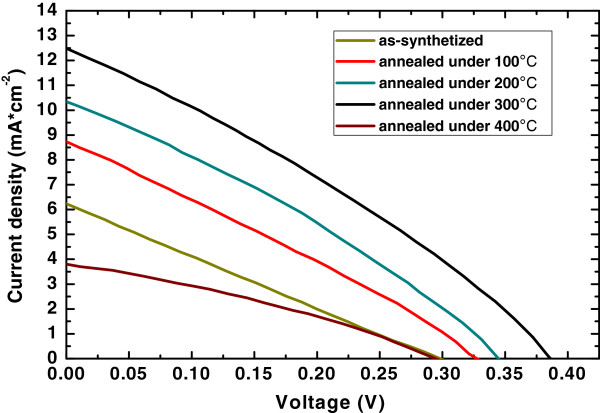
I-V curves for the solar cells assembled using Sb2S3-TiO2 nanostructures annealed under varied temperature.